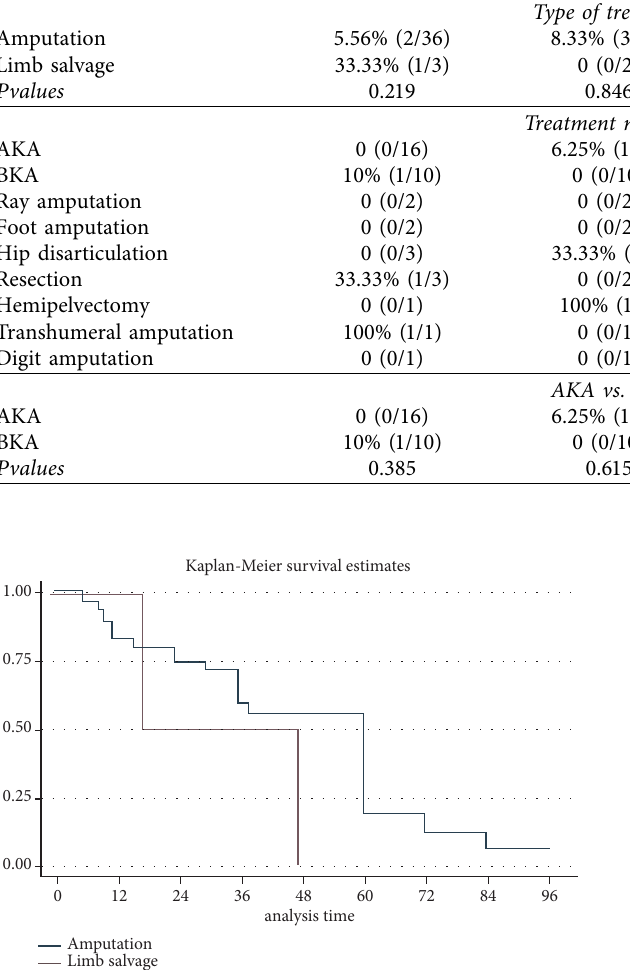
Figure 3: Kaplan–Meier survival curve for patients with COM- derived SCC who underwent amputation or a limb salvage pro- cedure. Log-rank analysis showed no difference between the groups ( p � 0 .